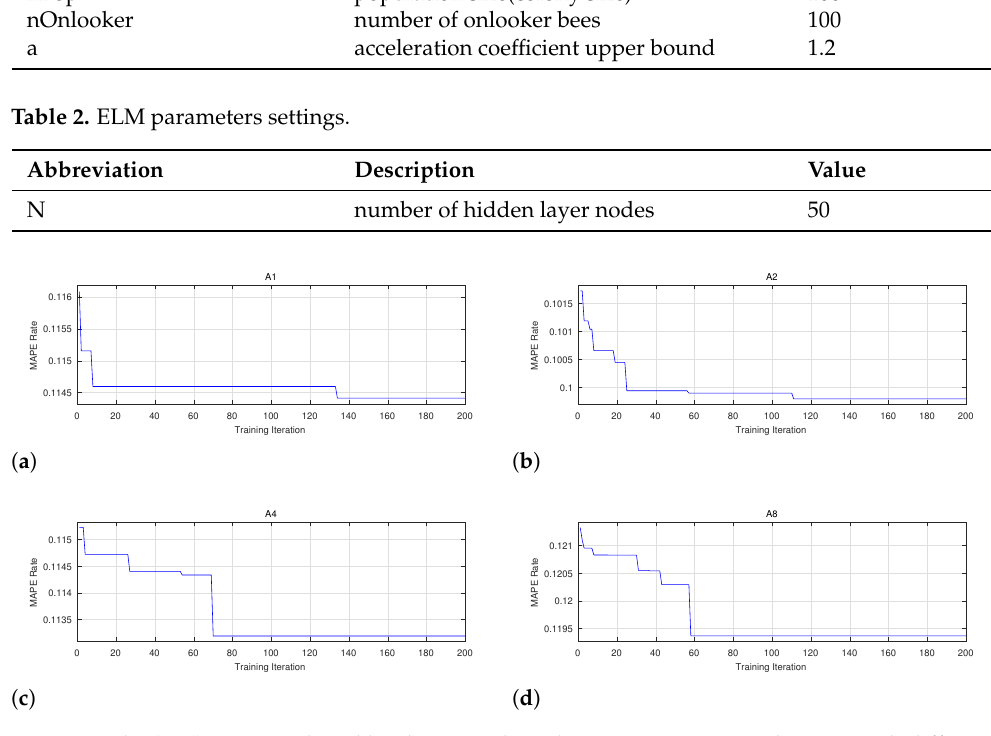
Figure 4. The ( a – d ) were predicted by the ABC algorithm on A1,A2,A4,A8 datasets with different numbers of iterations. The MAPE of the function tends to stabilize when the number of iterations exceeds